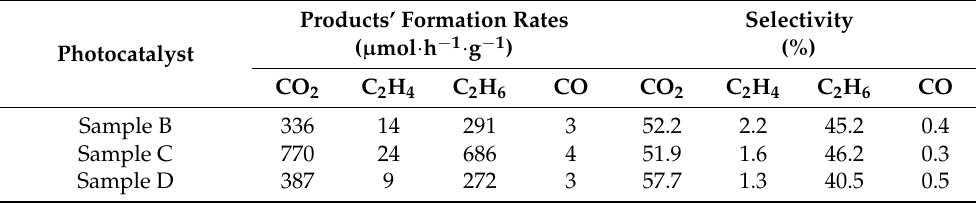
Table 3. Products’ formation rates of Pd/ZnO photocatalysts synthesized by BRM with different Pd wt% loading.